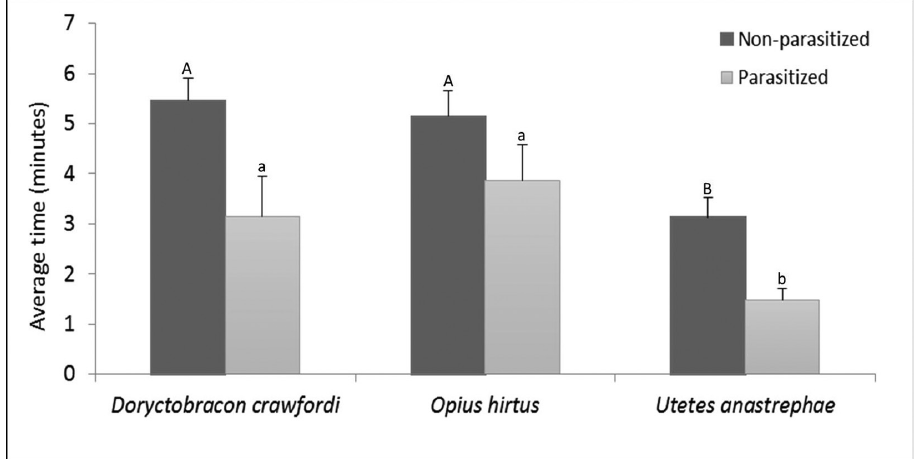
Figure 4. Latency (average ± SE, in minutes) between ovipositions of three native opine parasitoids at- tacking non-parasitized and previously parasitized Anastrepha ludens larvae. Different capital letters indicate statistically significant difference between the bars. Different letters, indicate statistically significant differ- ence between the bars. Different lower case letters, indicate statistically significant difference between